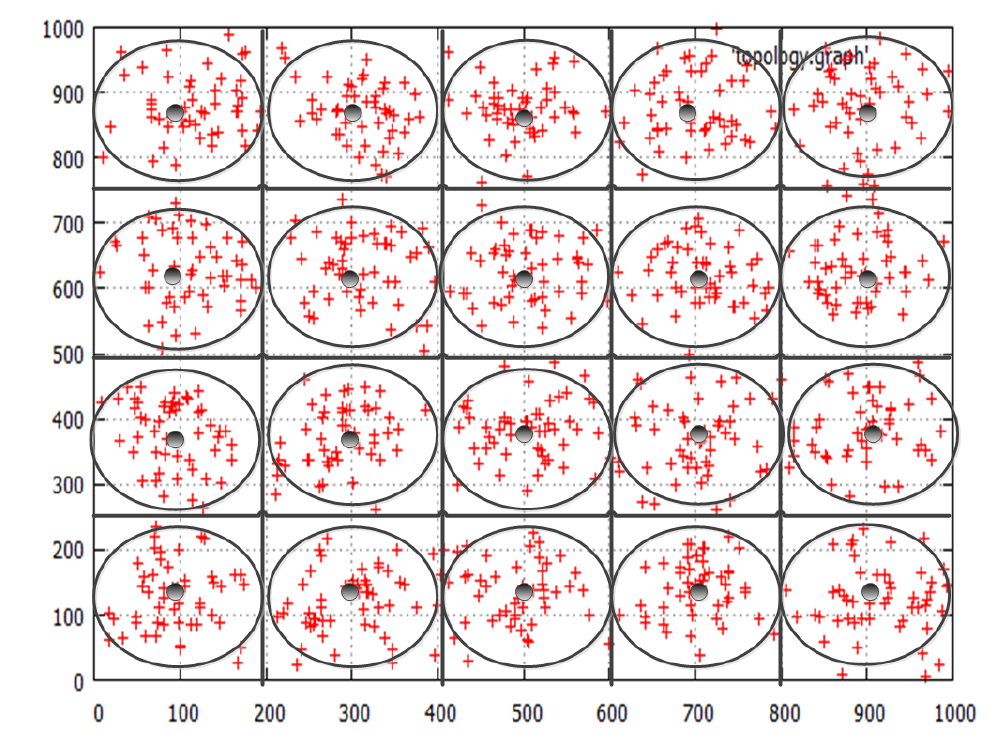
Figure 1. Group-deployed sensor network